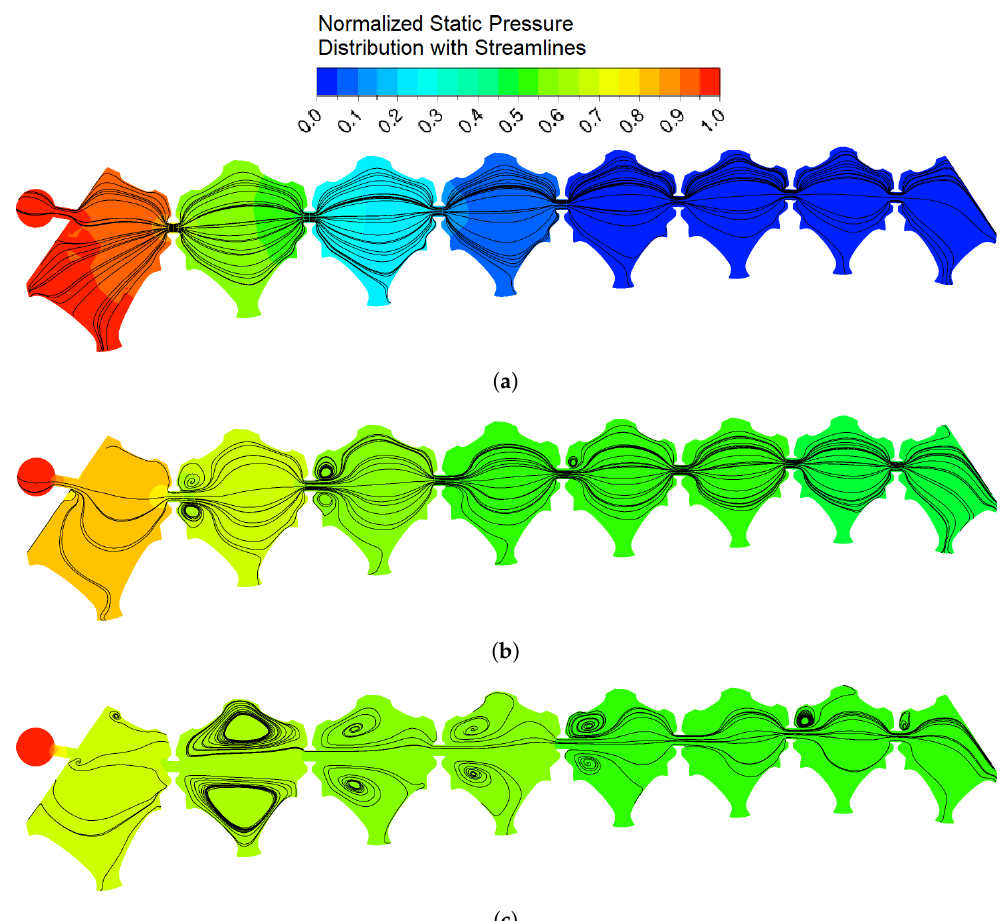
Figure 6. Normalized static pressure distribution for the fast filling process in x-y plane view at mid-span at different time steps: ( a ) t = 0.001s. ( b ) t = 0.005s. ( c ) t =